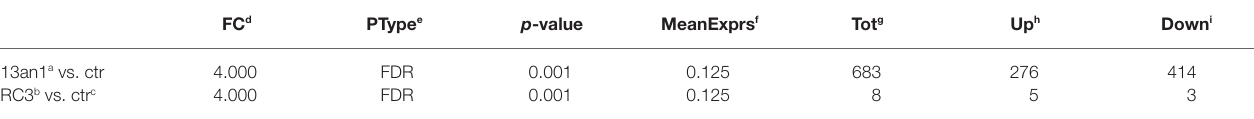
TABLE 1 | Summary of RNA-seq analysis of H. annosum 94233-RC3 and 94233 infected with HetPV13-an1 and 94233/32D, which is a partitivirus-free isogenic